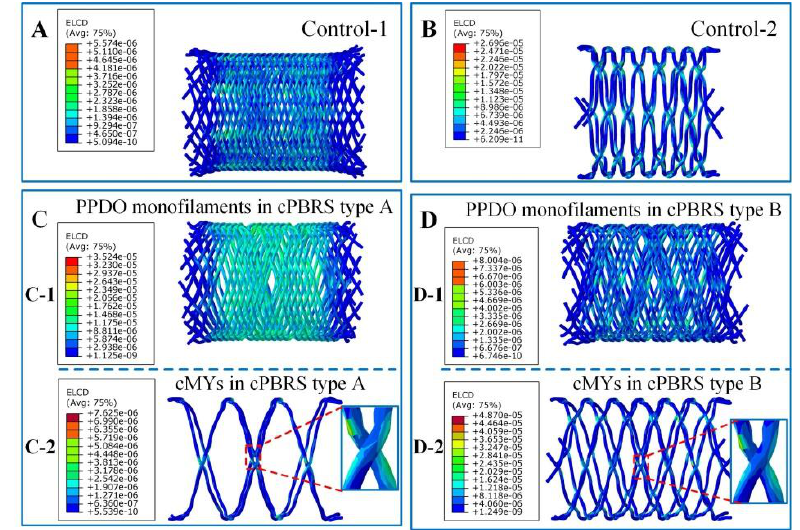
Figure 11. Creep dissipation energy distributions of different prototypes after the balloon-expanding simulations. ( A ) The Control-1 prototype. ( B ) The Control-2 prototype. ( C ) Different components of the cBPRS type A prototype: ( C-1 ) The PPDO monofilaments; ( C-2 ) The cMYs. ( D ) Different components of the cBPRS type B prototype: ( D-1 ) PPDO monofilaments; ( D-2 ) cMYs.